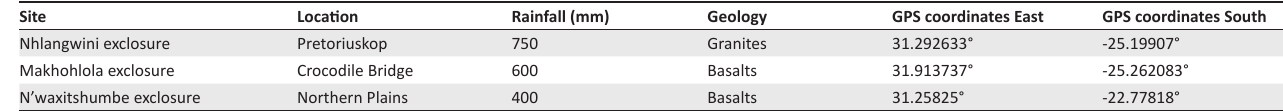
TABLE 1: Site names, locations and descriptions of the exclosures in the Kruger National Park where sampling took place. Site